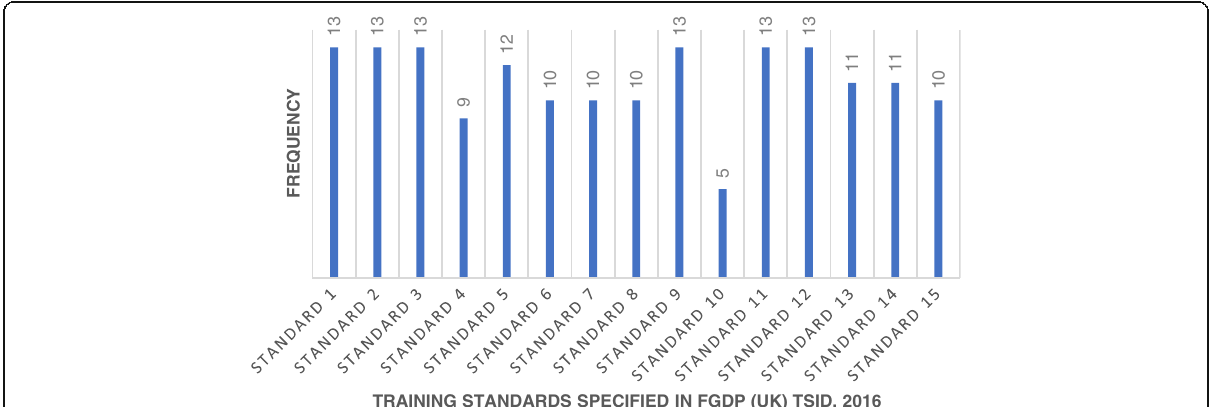
Fig. 1 The frequency of each training standard covered by CPD courses